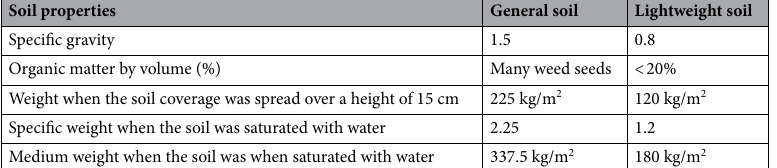
Soil properties General